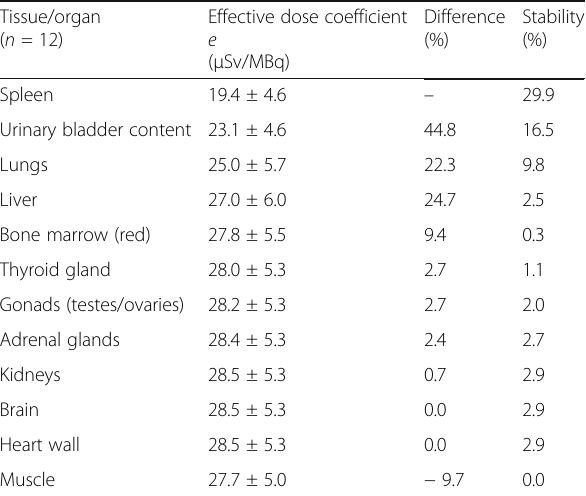
Table 6 Impact of number of tissues/organs for CE stylized reference phantoms using ICRP Publication 60 tissue weighting factors, w T , to calculate the effective dose coefficient, e , with the SD. The difference in percent calculated according to Eq. 4 and stability according to Eq. 5